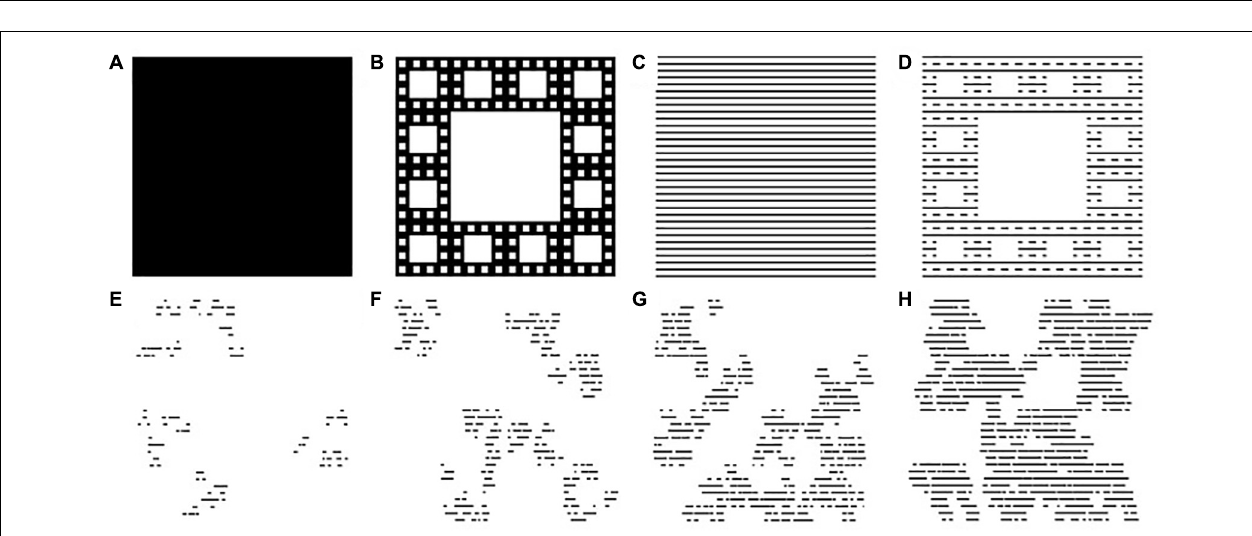
FIGURE 2 | Fractal ‘trees.’ (A) The seed growth starts with a filled square; (B) a square-shaped seed is used to grow a Sierpinski fractal pattern with D = 1.8; (C) the black background is replaced with a line construction; (D) a square-shaped seed is used to grow a Sierpinski pattern superimposed on this lined background. The patterns are then randomized to morph the exact fractal into a statistical fractal. The D -value of the final fractal is inputted during this growth process. Four examples are shown here: (E) 1.2, (F) 1.4, (G) 1.6, and (H)